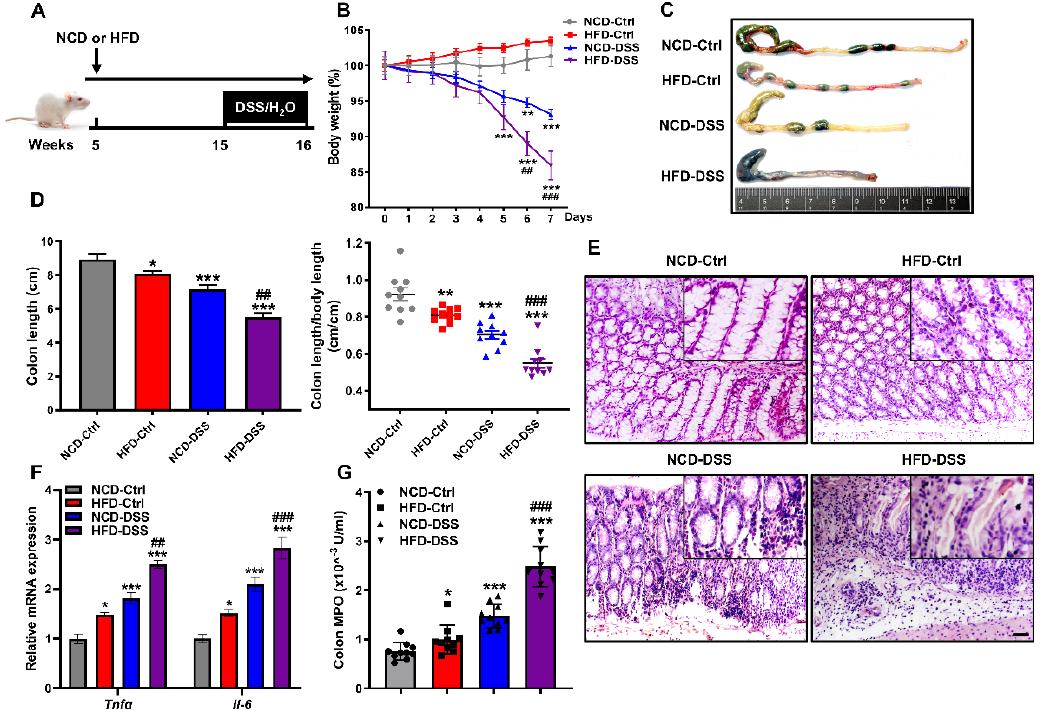
Figure 1. Obesity aggravates the severity of DSS-induced colitis. ( A ) Schematic diagram of DSS-induced experimental colitis in mice. Male CD1 mice were fed with NCD or HFD for 10 weeks. To induce colitis, mice were additionally given 3% DSS by drinking water for 7 days. Mice were sacrificed on day 7 with DSS treatment, and colons were collected for analysis. ( B ) Bodyweight changes. ( C ) Representative images of the colon’s appearance. ( D ) Statistical data of the colon length. ( E ) Hematoxylin and eosin (H&E) staining of colon sections. Scale bar = 50 μm. ( F ) The mRNA expression levels of the proinflammatory genes Tnf α and Il-6 were measured by real-time PCR in the colon. ( G ) Colon MPO levels. Values are presented as the mean ± SEM. n = 10. * p < 0.05, ** p < 0.01, *** p < 0.001 compared with NCD-Ctrl; ## p < 0.01, ### p < 0.001 versus NCD-DSS.